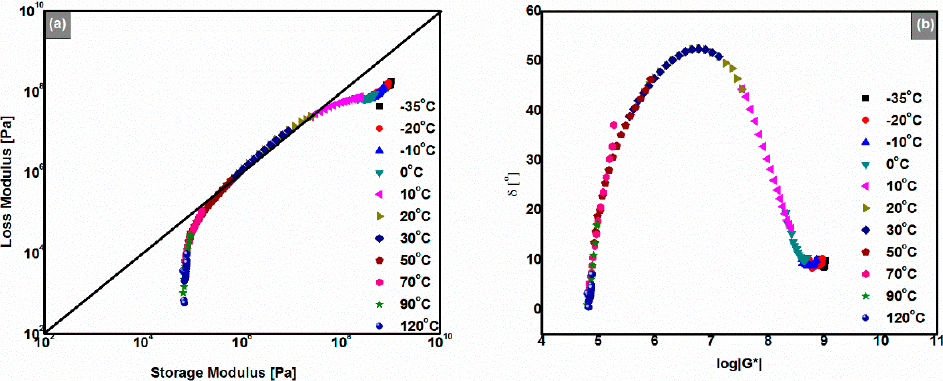
Figure 6. ( a ) Cole–Cole plot of the 180#; ( b ) Black diagram of the 180#.